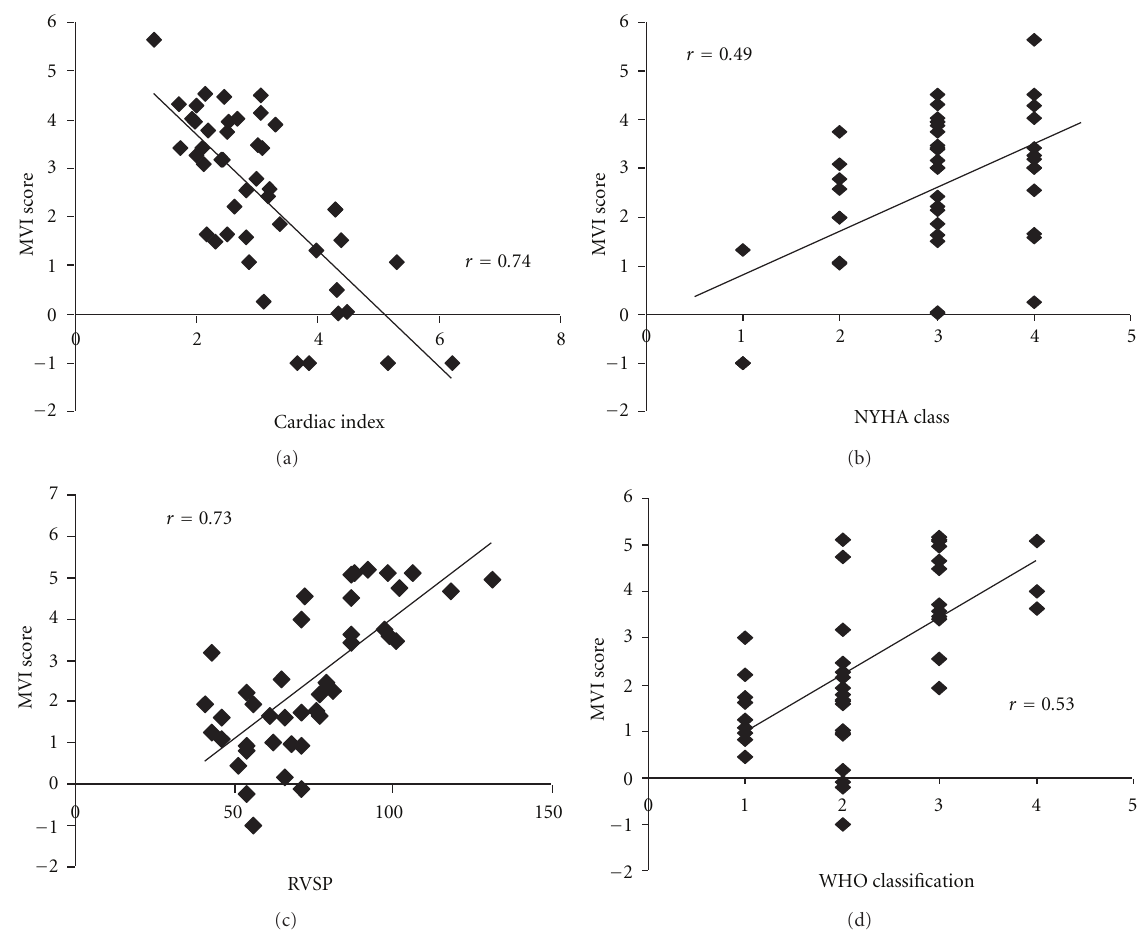
Figure 7: Relationships of MVI score with clinical